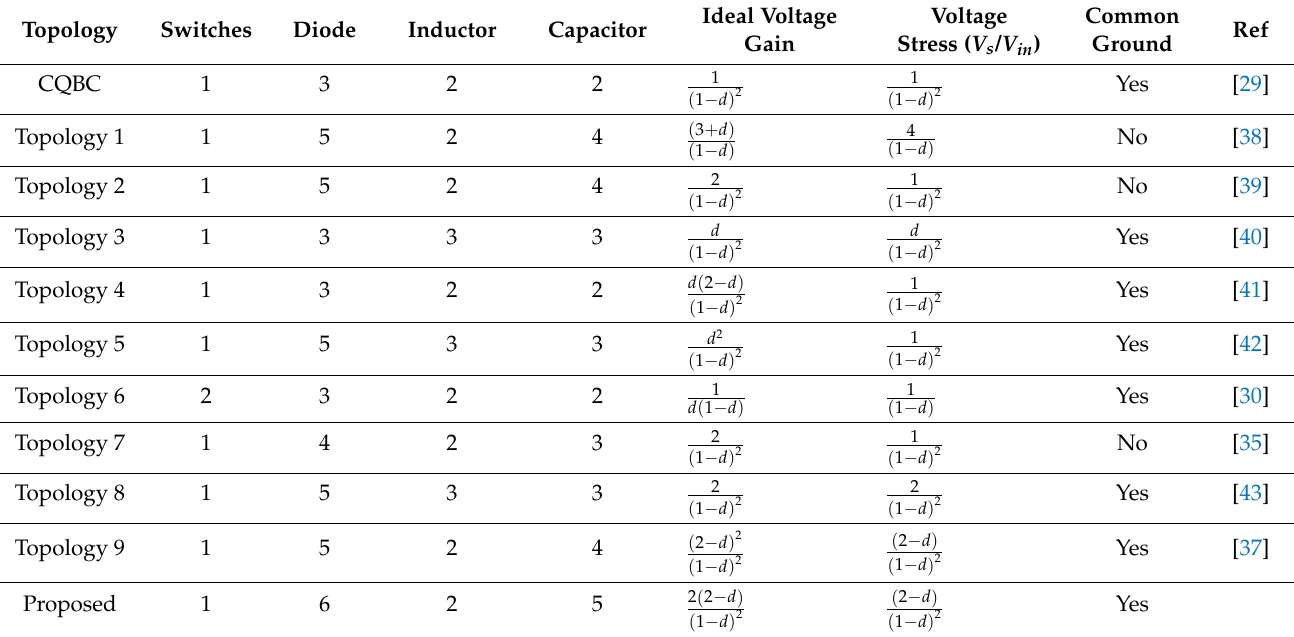
Table 1. Comparison with a similar non-Isolated boost